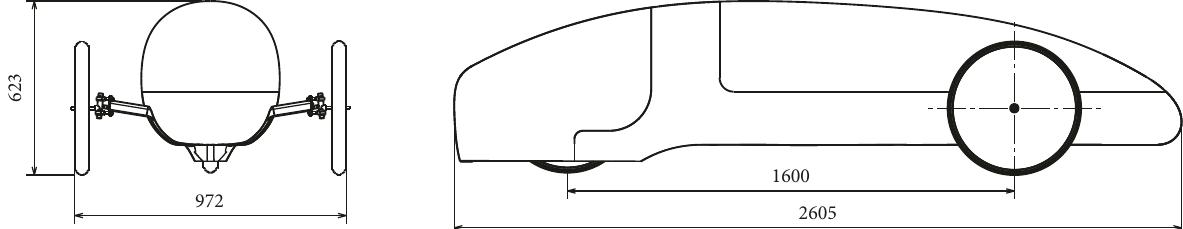
Figure 10: Dimensions of the vehicle.